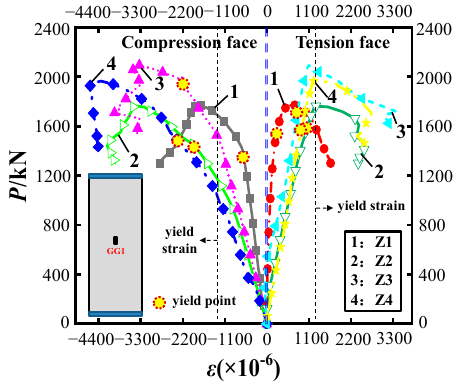
Figure 10. Steel tube load–longitudinal strain curve.